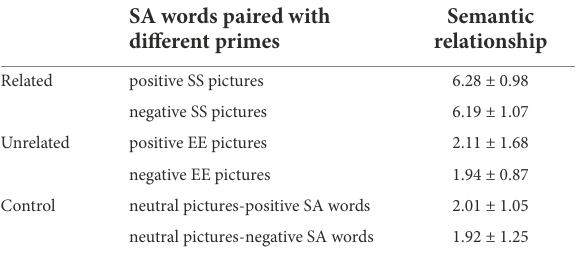
TABLE 2 The rating scores of semantic relationships between prime pictures and SA words. SA words paired with different